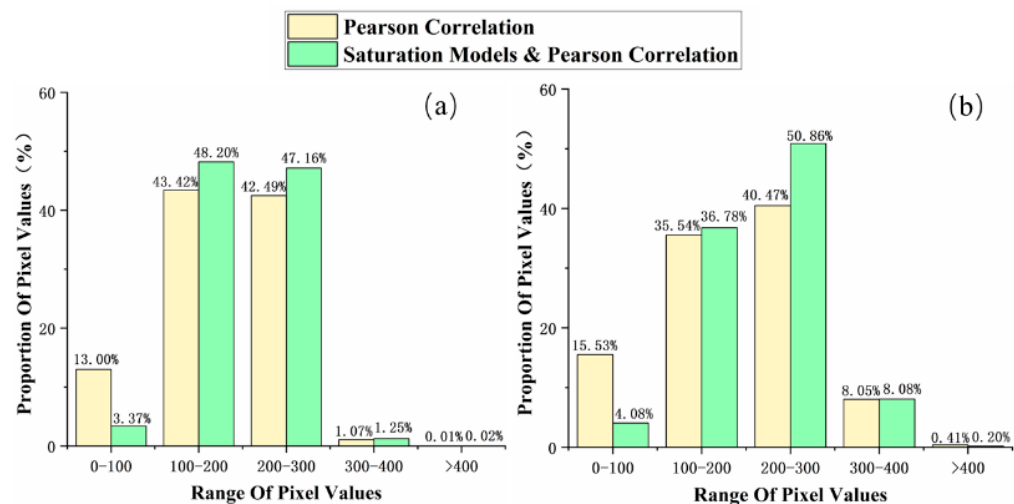
Figure 9. Histograms of estimated GSV derived from RF for GF-1 images and from SVM for Sentinel-2 images.